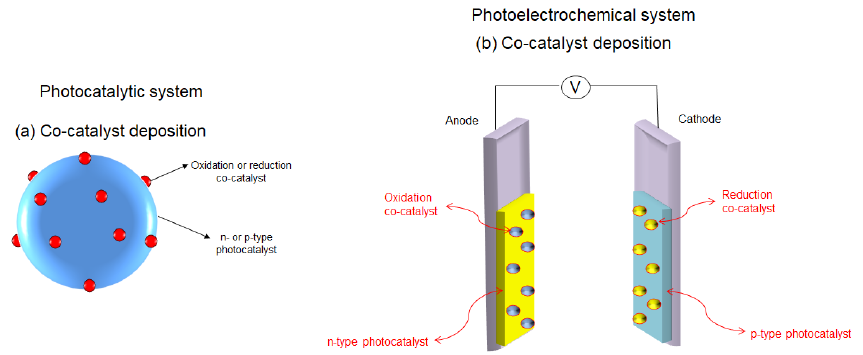
Figure 14. The schematically representation of ( a ) photocatalyst; ( b ) photoelectrode loaded by co-catalysts. Adapted from reference [168].